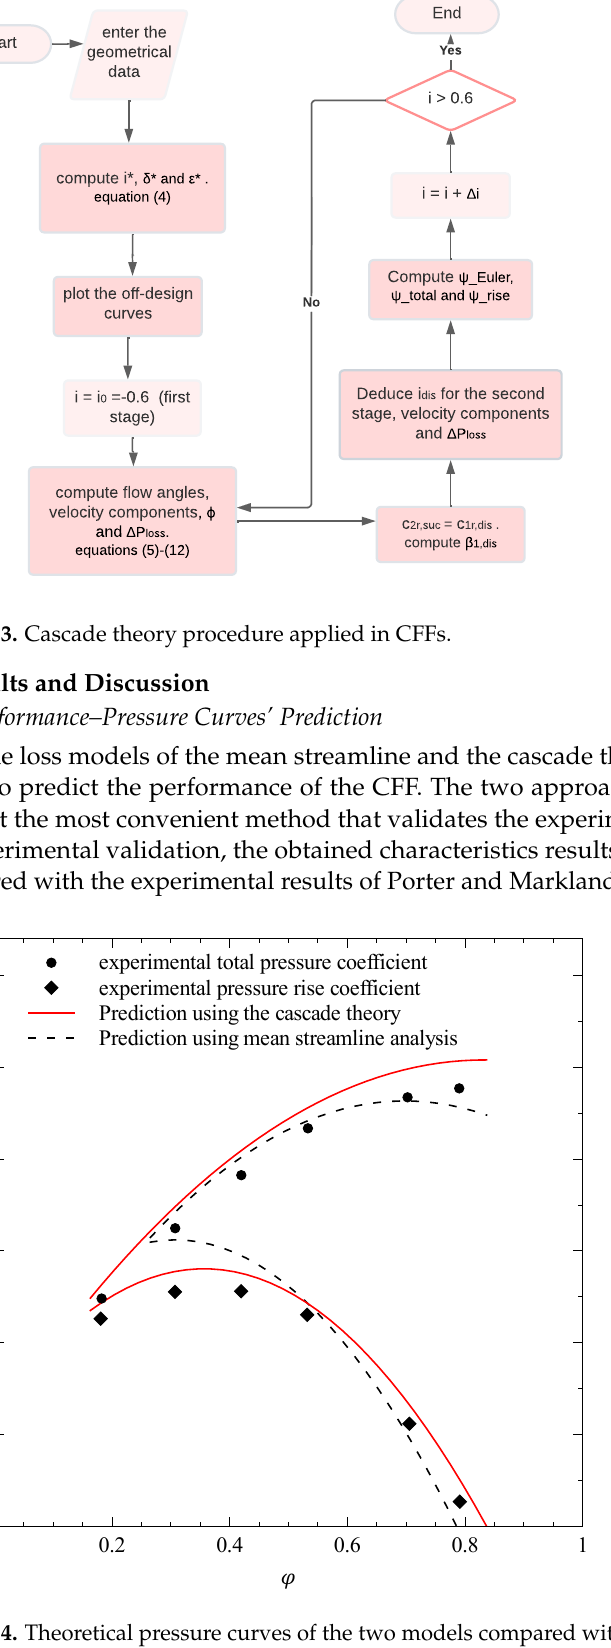
Figure 14. Theoretical pressure curves of the two models compared with the experimental results for 2250